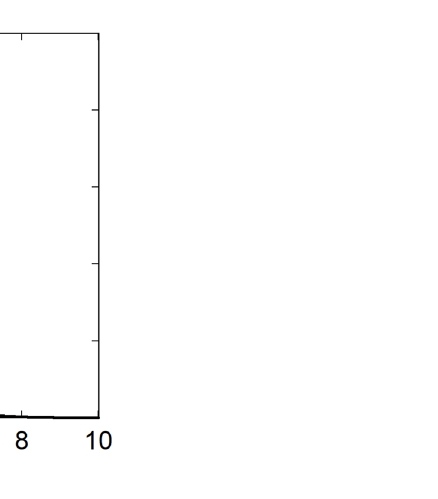
Figure 1. Magnetic structure of FeTiO 3 . Every other Fe atom (brown ball) slightly buckles along the c -axis. The spin (red arrow) directs along the c -axis with a small tilting of about 2° 10 . The nearest-neighbor bonds (brown rods) between Fe spins with r = 3.05 Å form a honeycomb lattice in the ab -plane.